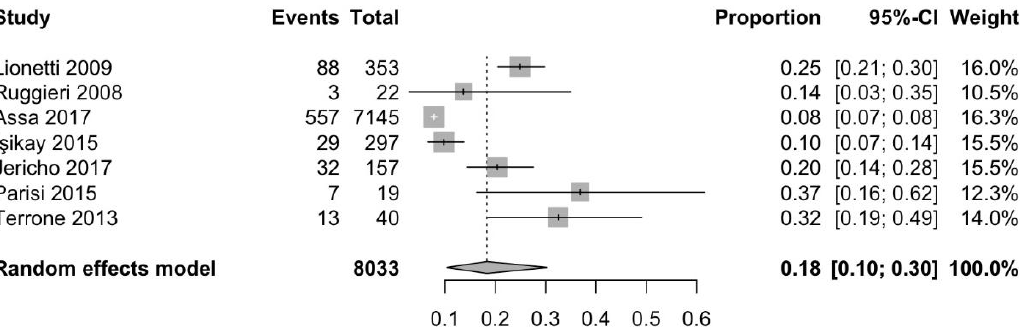
Figure 4. Pooled mean prevalence of headache in children with coeliac disease.